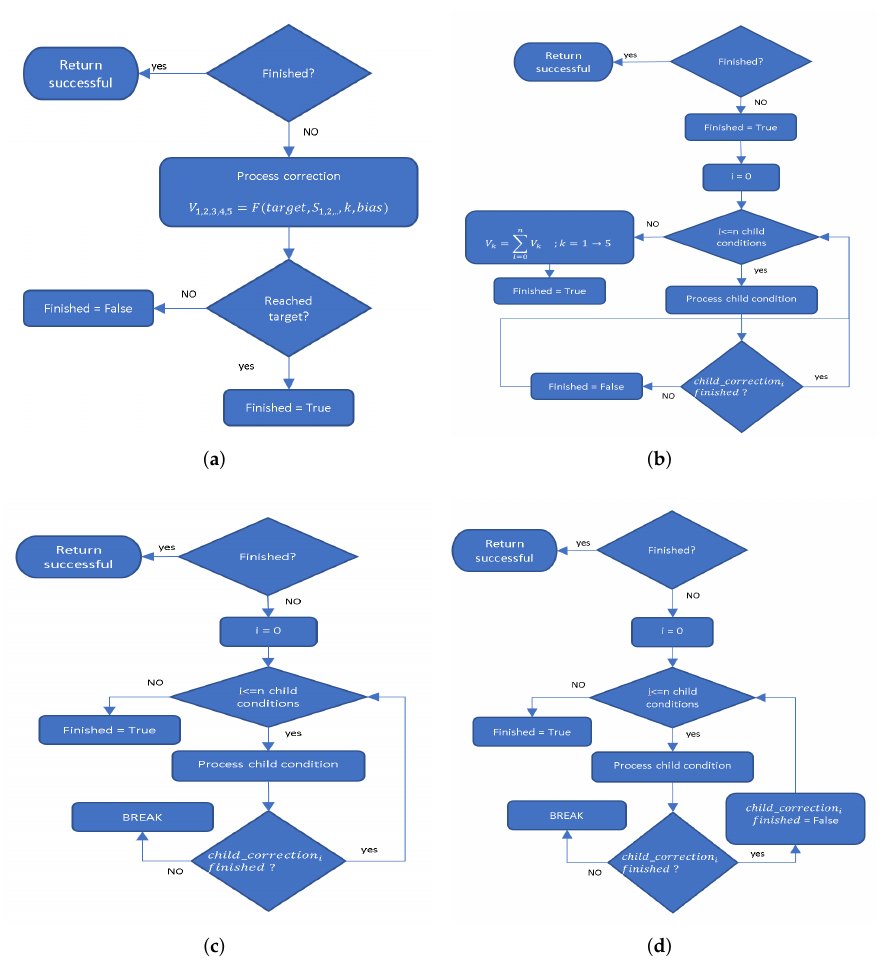
Figure 3. Control Types: ( a ) single correction; ( b ) parallel corrections; ( c ) sequential corrections; and ( d ) semi-sequential